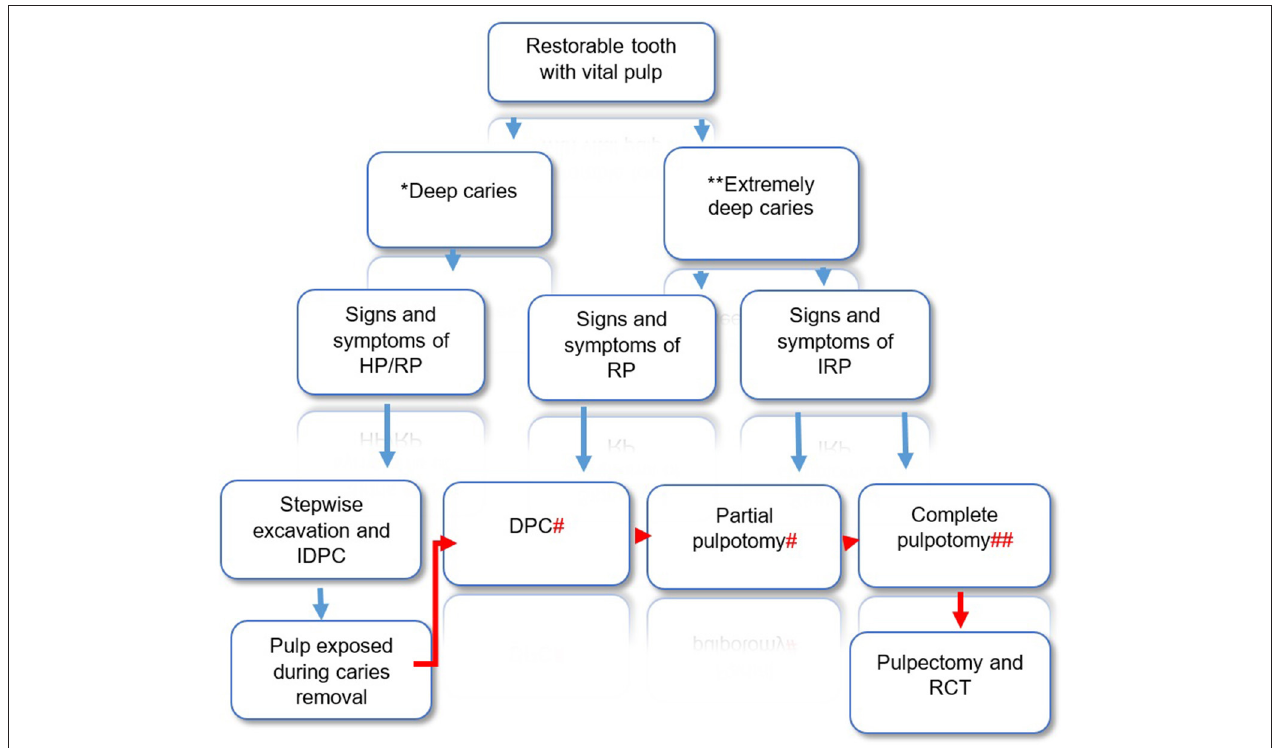
FIGURE 1 | Decision making for VPT in restorable teeth with deep and extremely deep caries and positive response to sensibility testing. Diagram illustrating suggested clinical pathway and treatment options based on clinical findings. The suggested pathway is based on ESE position statement on the management of deep caries and exposed pulp ( 2), augmented with authors perspective, *Caries extend into the pulpal quarter of the dentine, but with a well-defined zone of radiopaque dentine separating the infected demineralized dentine from the pulp. **Caries involve the entire thickness of the dentine, without a radiopaque zone separating the lesion from the pulp. # bleeding can be controlled within 5min, ## bleeding controlled within 5min and no sign of necrosis in any canal. HP, healthy pulp; IDPC, indirect pulp capping; RP, reversible pulpitis; IRP, irreversible pulpitis.